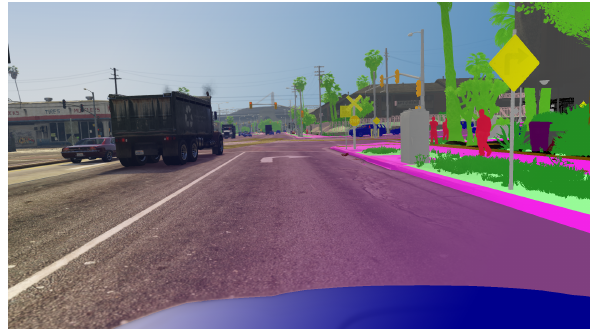
Figure 1. Blanding of a synthetic RGB street scene image and the corresponding semantic ground truth image (Richter et al., 2017). Traffic signs are labelled in yellow.